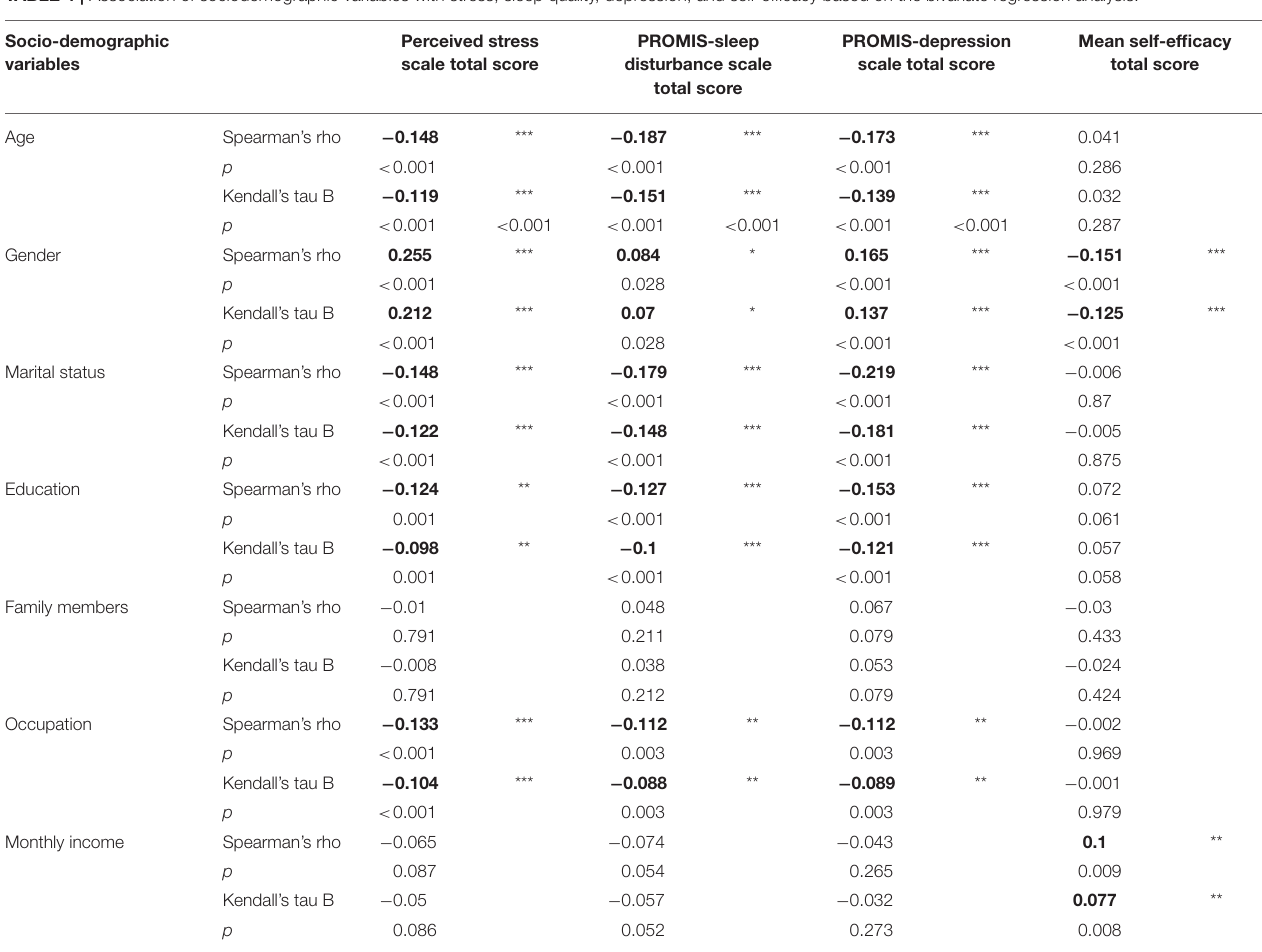
TABLE 4 | Association of sociodemographic variables with stress, sleep quality, depression, and self-efficacy based on the bivariate regression analysis. Socio-demographic